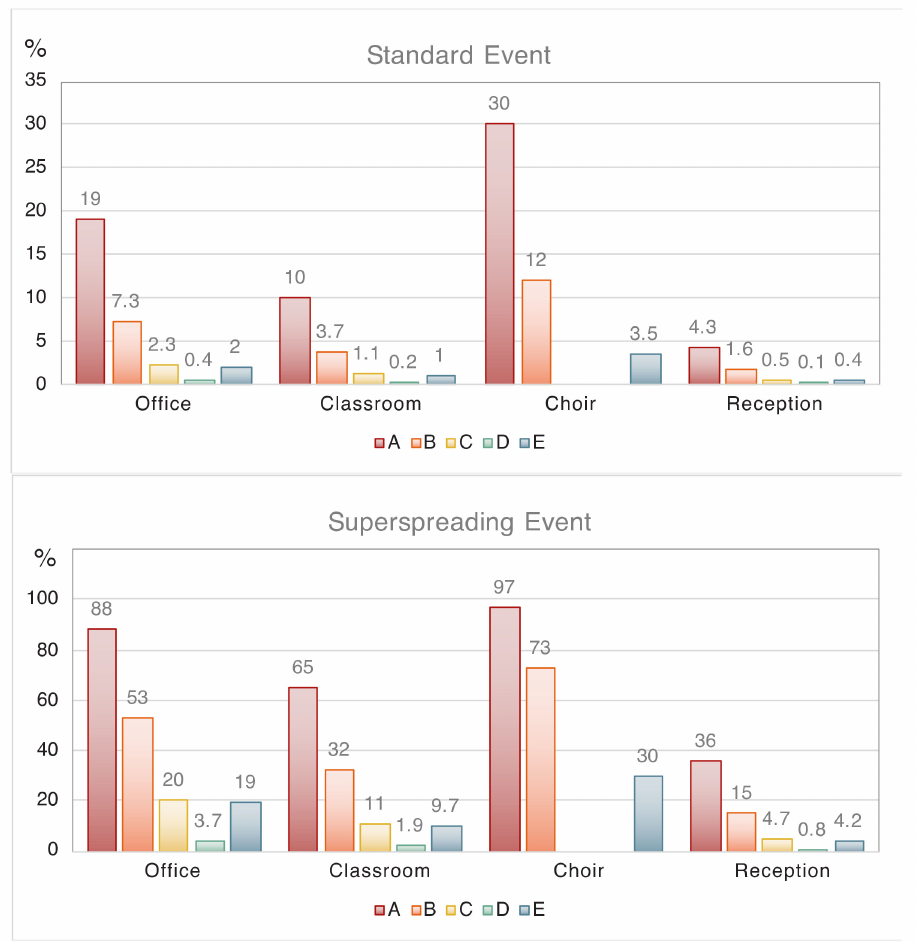
Figure 1. Individual risk of a particular person being infected (equivalent to the percentage of the group being infected) in four indoor environments and five scenarios, for standard and superspreading conditions. Scenario A : passive ventilation, no masks. Scenario B : active ventilation with outside air, no masks. Scenario C : active ventilation, facial masks (not for choir). Scenario D : active ventilation, high-quality masks (not for choir). Scenario E : high-volume filtration with